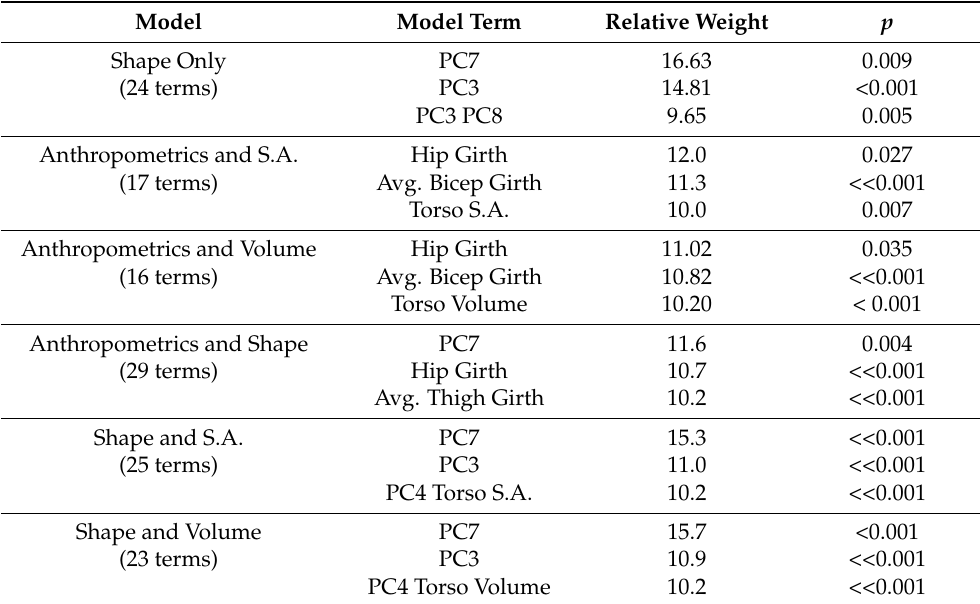
Table 6. Relative weights and associated significances for model terms predicting distribution of